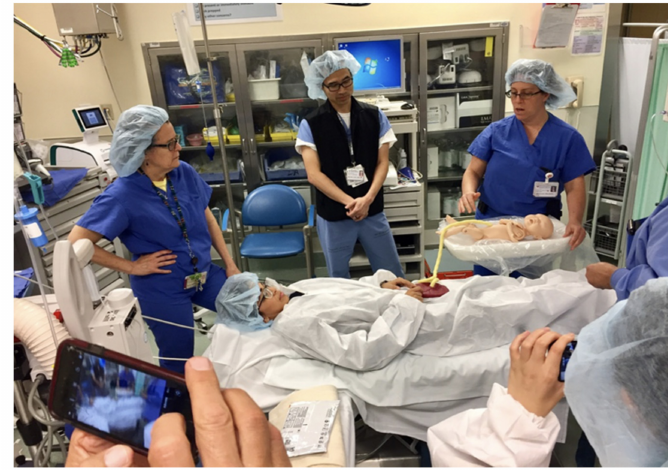
Figure 2. Delayed cord clamping cart in use during a